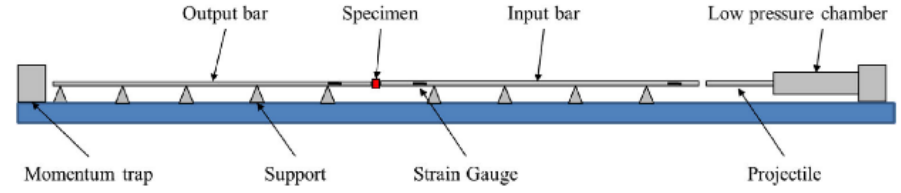
Figure 7. Long split Hopkinson bar setup (reprinted from Ref. [74]).